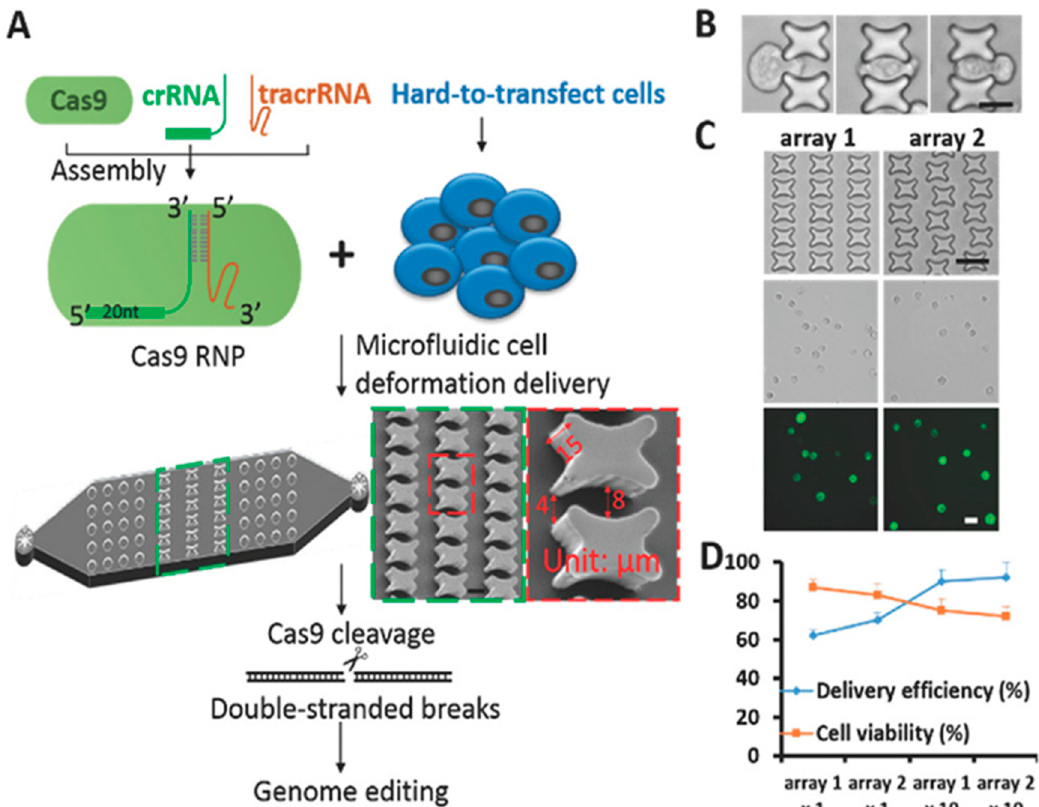
Figure 2. Cas9 RNP delivery strategy and chip performance. ( A ) Experimental scheme of Cas9/crRNA/tracrRNA ribonucleoprotein (Cas9 RNP) delivery for genome editing in hard-to-transfect cells via a microfluidic cell deformation chip. Scanning electron microscopy of deformable zones in the device is also shown. Scale bar, 10 µ m. The red arrow indicates one curved tunnel with a depth of 15 µ m and a width of 4–8 µ m. ( B ) Cell deformation was shown by microscopy when SK-BR-3 cells passed through the micro construction: scale bar, 10 µ m. ( C ) Microscopy of SK-BR-3 cells into which FITC-labeled 70 kDa dextran molecules were delivered through different chip designs. Arrays 1 and 2 show cell passage curved tunnels formed by different structural arrangements. Scale bar, 20 µ m. ( D ) Delivery efficiency and cell viability 16 h after treatment were calculated for ( C ) at a fluid speed of 150 µ L min − 1 . Array 1 × 10 or array 2 × 10 indicates cells passing through a chip with 10 repeats of identical cell deformation zones. Error bars indicate SEM ( n = 3). (Reproduced with permission from [95] Copyright 2020